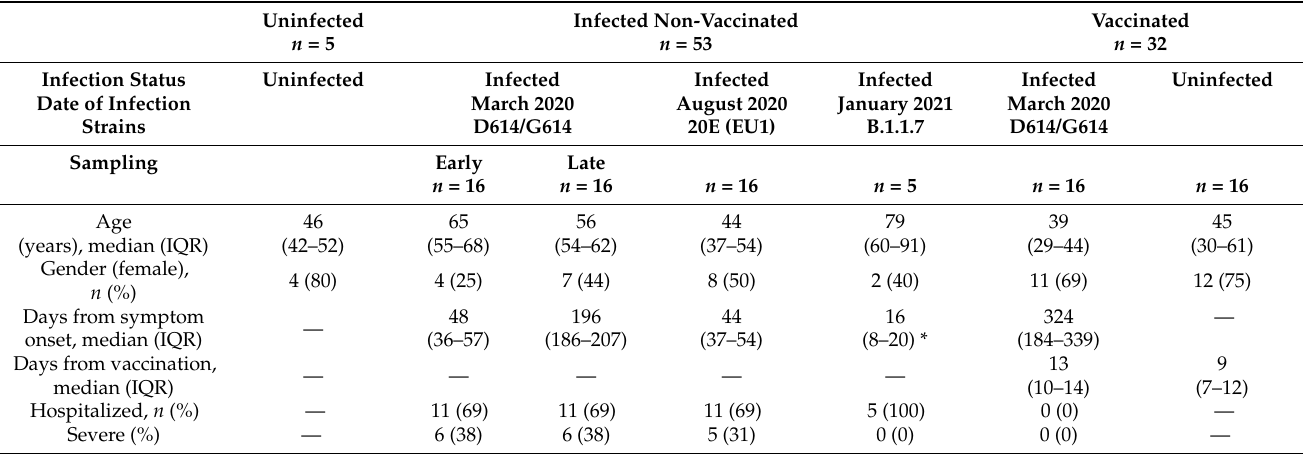
Table 1. Description of participants. Uninfected individuals were included as negative controls for neutralizing activity. All of them showed undetectable neutralizing activity. IQR: interquartile